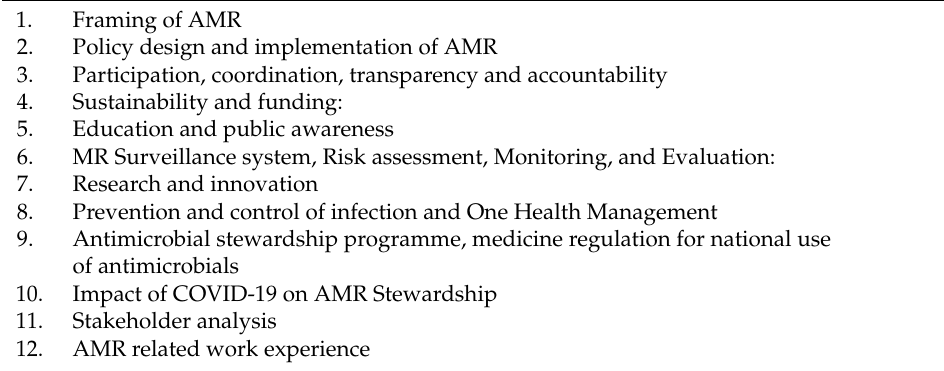
Table 1. Domains explored in the IDI guideline